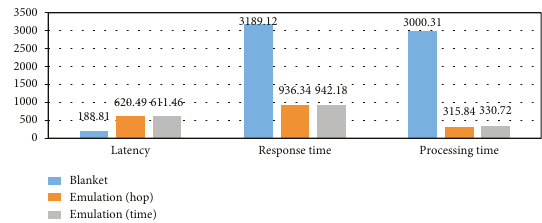
Figure 17: Comparison of performance between di ff erent test modes.